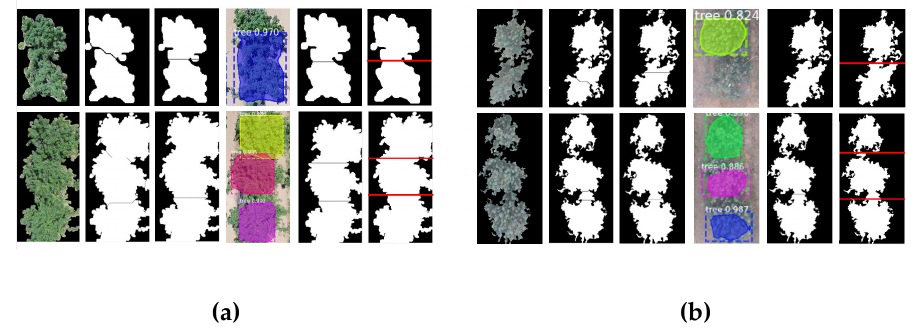
Figure 15. Segmentation results of canopies in different degrees of intermingledness: ( a ) image segmentation results of severely overlapping samples; ( b ) image segmentation results of lightly crossing samples. In each group, from left to right: original images, traditional Watershed, improved Watershed, Mask-RCNN, our algorithm results, and the ground truth.